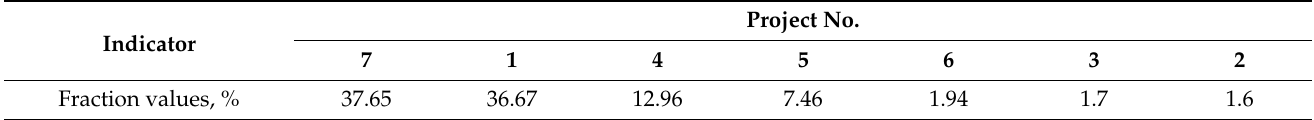
Table 2. Results of ranking of projects of procurement of raw materials from corn waste by their specific value and